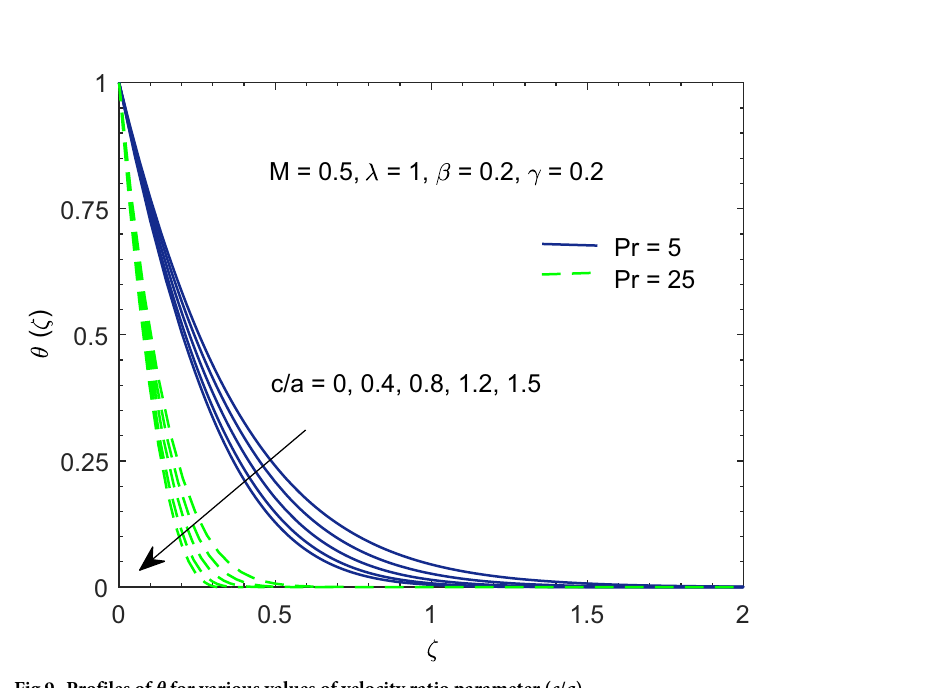
Fig 9. Profiles of θ for various values of velocity ratio parameter ( c / a ).